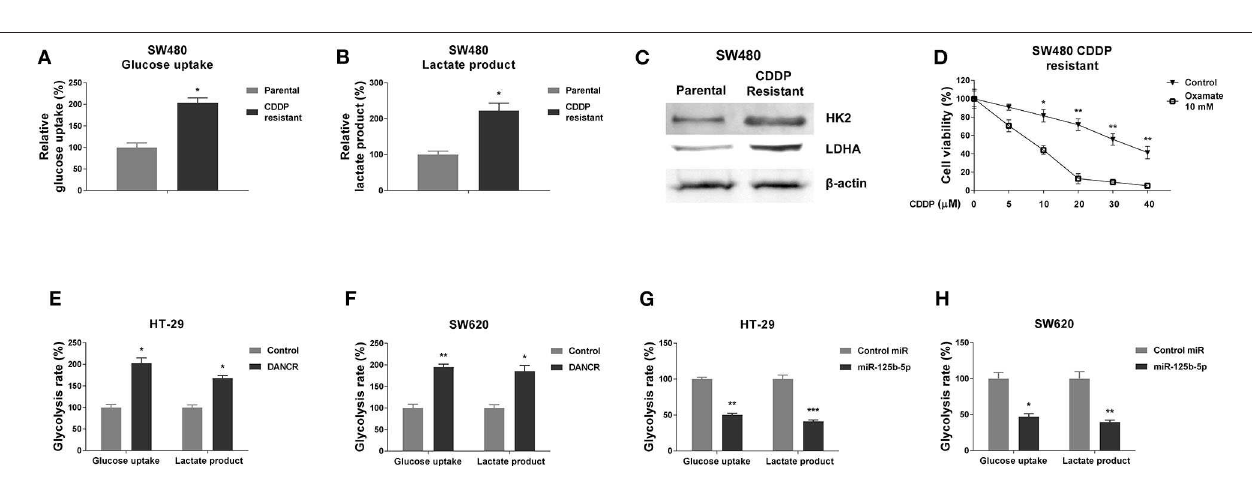
FIGURE 4 | DANCR and miR-125b-5p oppositely regulate glycolysis of gastric cancer cells. (A) Glucose uptake and (B) lactate product were measured in SW480 parental and cisplatin-resistant cells. (C) Protein expressions of HK2, LDHA were detected in SW480 parental, and cisplatin-resistant cells by Western blot. β -Actin was an internal control. (D) SW480 cisplatin-resistant cells were cotreated with control or oxamate at 10mM plus cisplatin at the indicated concentrations for 48h; the cell viability was measured by MTT assay. (E) HT-29 and (F) SW620 cells were transfected with control vector or DANCR overexpression vector for 48h; the glucose uptake and lactate product were measured. (G) HT-29 and (H) SW620 cells were transfected with control miR or miR-125b-5p precursor for 48h; the glucose uptake and lactate product were measured. Data are presented as mean ± SD. * p < 0.05, ** p < 0.01, and *** p <